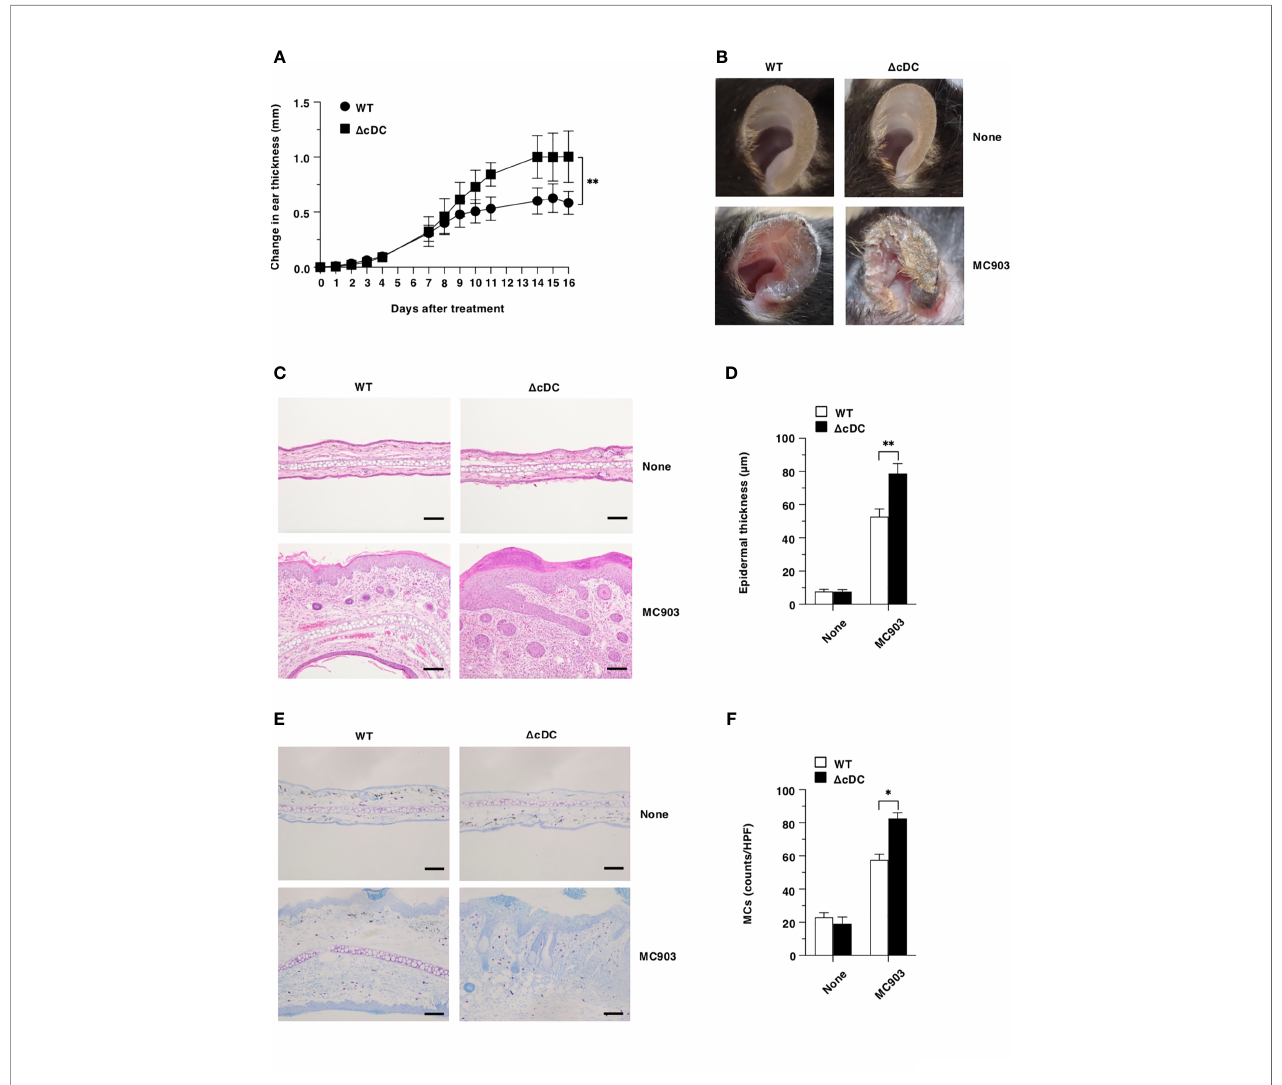
FIGURE 1 | Constitutive loss of cDCs aggravates the development of AD-like in fl ammation. (A, B) WT mice and D CD11c hi cDC mice (n = 14 per group) were treated topically with MC903 on the left ear skin. (A) Ear thickness was evaluated for 16 days. Data were obtained from fourteen individual samples in a single experiment. (B) Representative pictures of ear skin lesions at days 0 (None) and 16 (MC903). (C, D) Representative hematoxylin and eosin (H&E) sections (magni fi cation; 200x) of ear skin (C) , and epidermal thickness (D) was evaluated at days 0 (None) and 16 (MC903). Bars indicate 100 m m. Data were obtained from fi ve individual samples in a single experiment. (E, F) Representative toluidine blue sections (magni fi cation; 200x) for detecting MCs of ear skin (E) , and the quanti fi cation of MCs of the skin (F) at days 0 (None) and 16 (MC903). Bars indicate 100 m m. HPF, high performance fi eld. Data were obtained from three individual samples in a single experiment. * P < .05, ** P < .01 compared with WT mice by two-sided paired student t -test. All data are representative of at least 3 independent